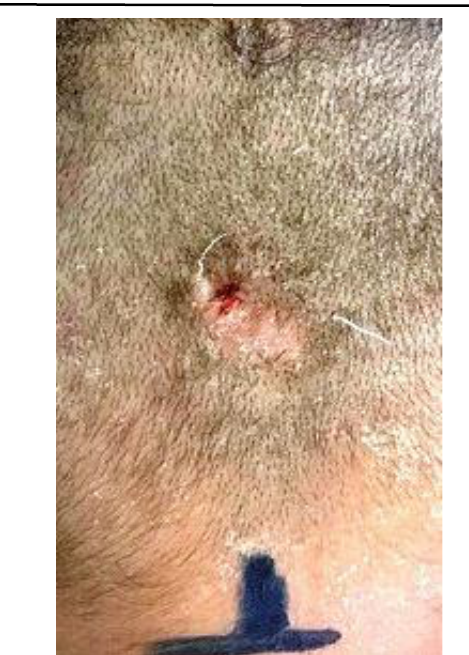
Fig.1.Cutaneous stigmata of occipital dermal sinus.